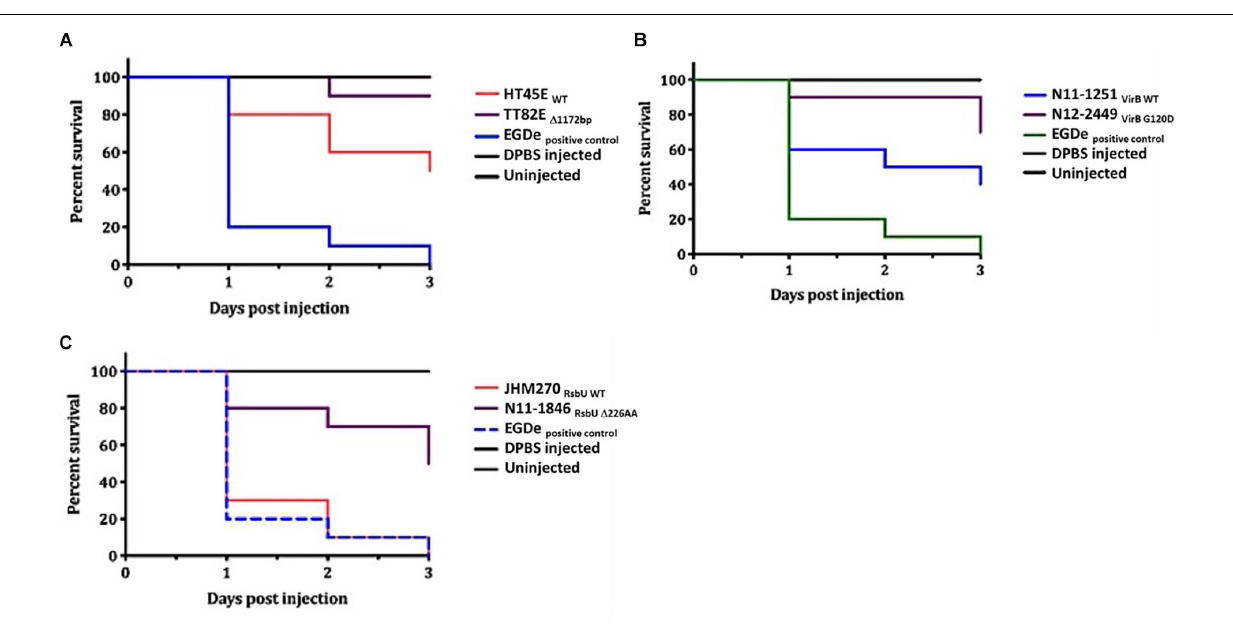
nisin concentration. Based on the strain specific nisin inhibition induced percentage change in area growth curve ( (cid:49) PAUC) most (66%) of the examined strains were nisin resistant at 12.5